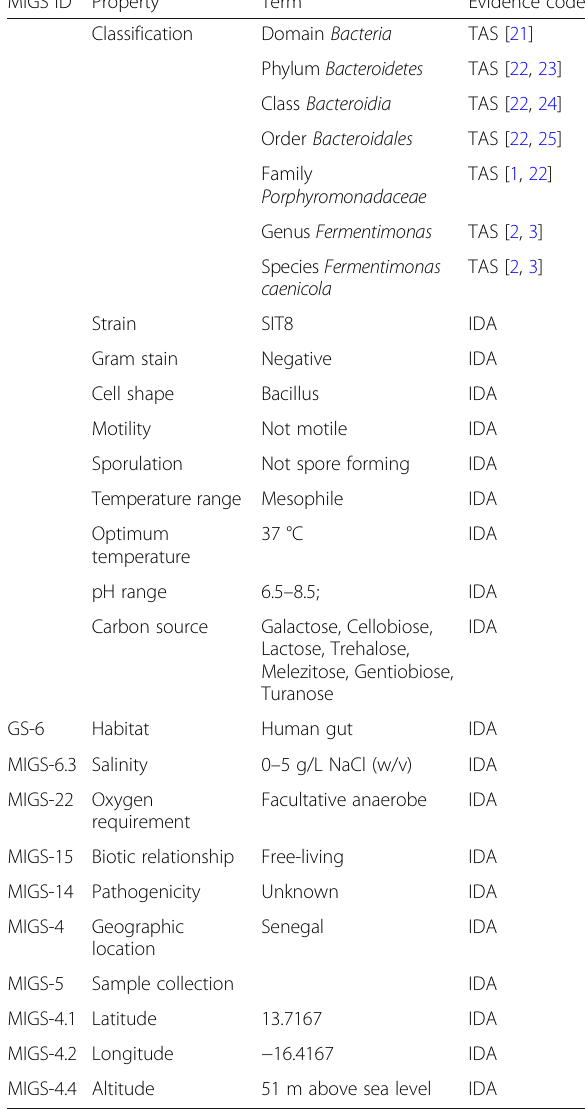
Table 1 Classification and general features of Fermentimonas caenicola strain SIT8 MIGS ID